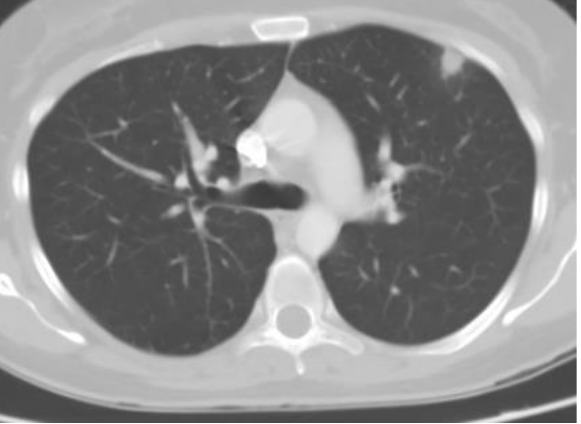
Figure 5. Incidental pulmonary nodule in a patient from a highly endemic area. Biopsies often reveal granulomatous changes and calcifications.